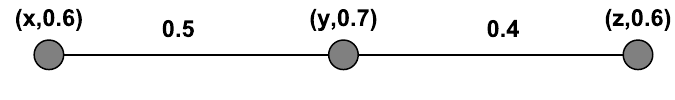
Figure 1: Fuzzy graph,